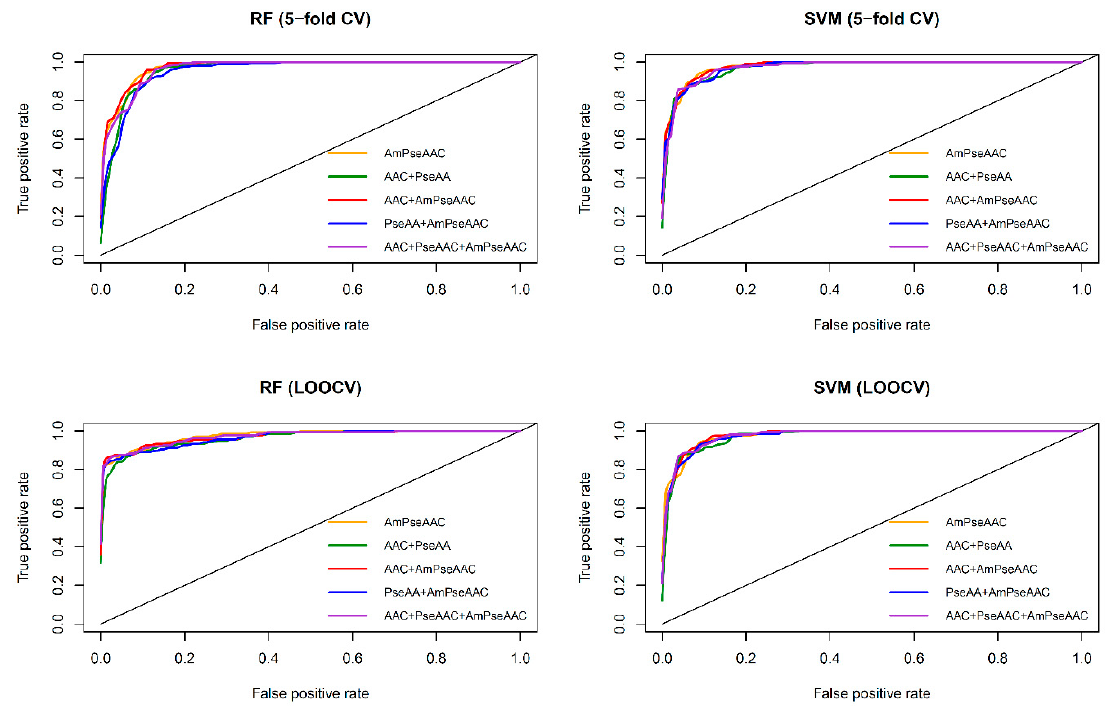
Figure 3. ROC curve of RF (top and bottom left) and SVM (top and bottom right) models as assessed by 5-fold cross-validation (top left and right) and jackknife test or leave-one-out cross-validation (bottom left and right).